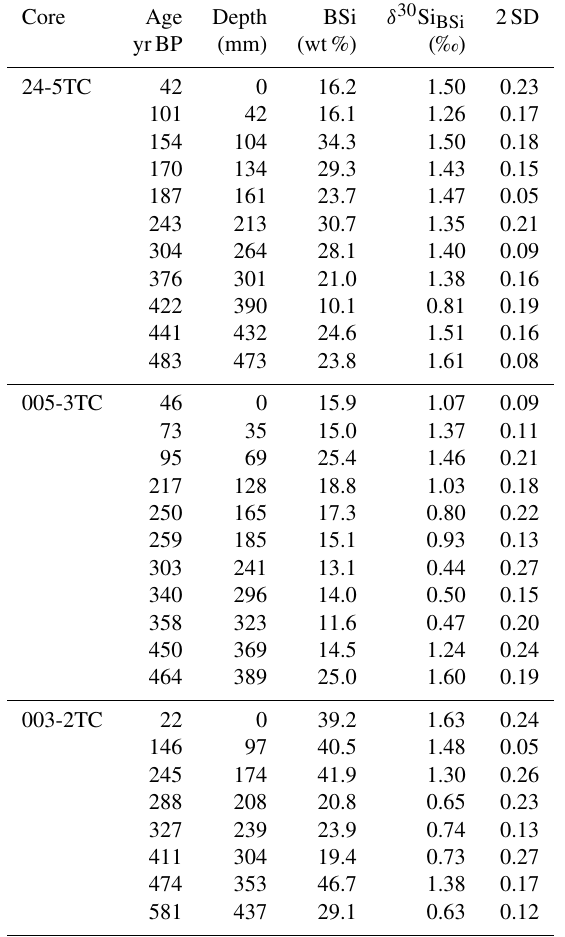
Table 1. Downcore record of core M77/2-024-5TC, M77/2-005- 3TC and M77/2-003-2TC for δ 30 Si BSi (‰) and BSi content (wt%). The 2SD represents the external reproducibility of repeated sample